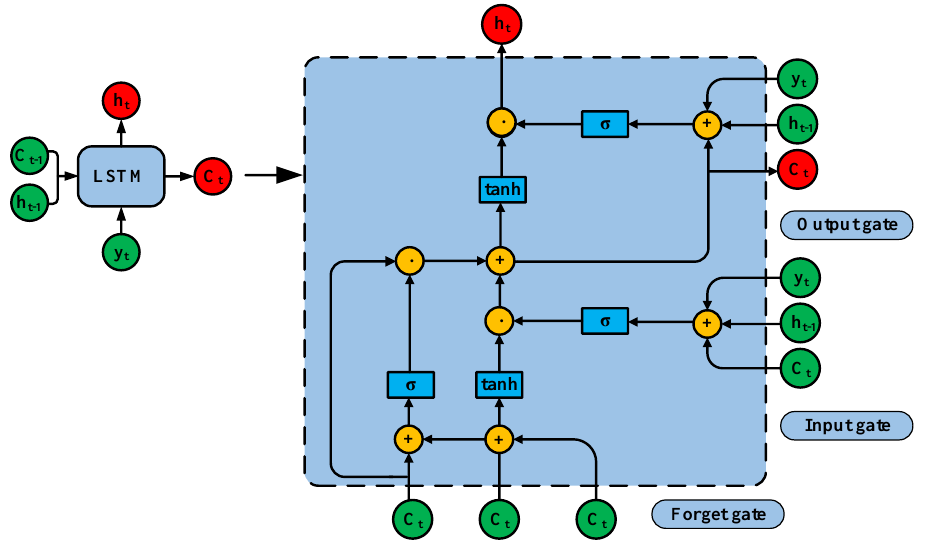
Figure 2. Recurrent unit structure of LSTM network.